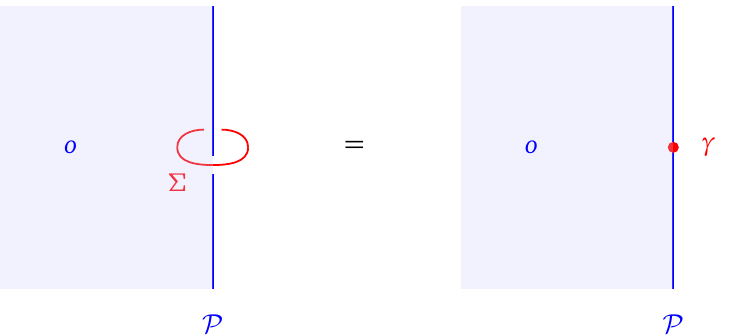
Figure 22: The bulk surface defect Σ labelled by v ∈ S links the o -twisted co- 6 d , o dimension-two defect P (left). The ‘squeezing’ operation gives a line defect γ labelled ( v ) = w by w ∈ W S (right). This implies π S P P